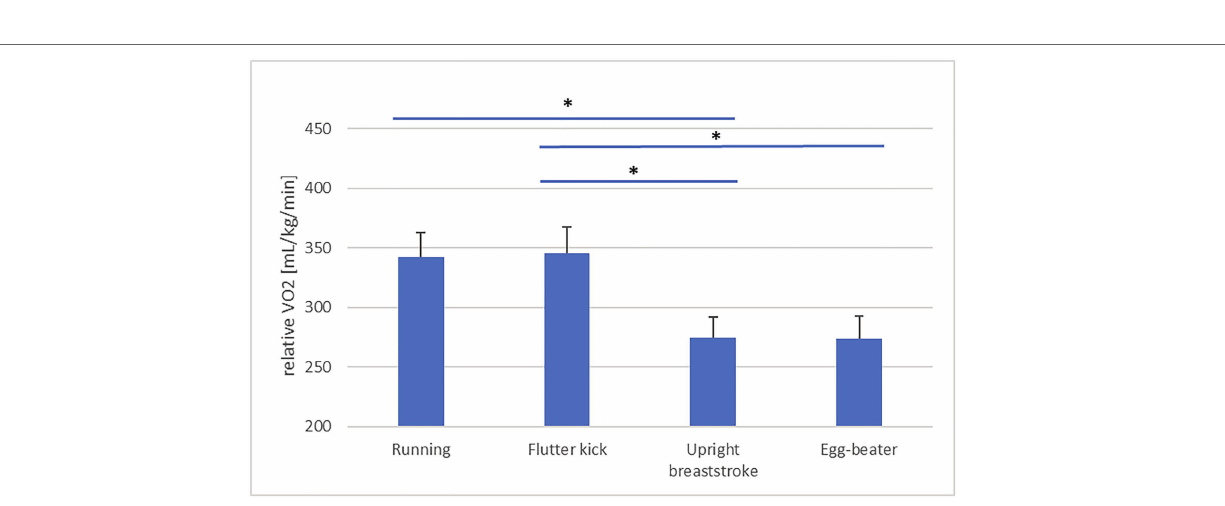
FIGURE 4 | Heart Rate (HR) during four treading water techniques in skilled treaders – means and SEs. * Denotes significant difference between techniques ( p corrected <